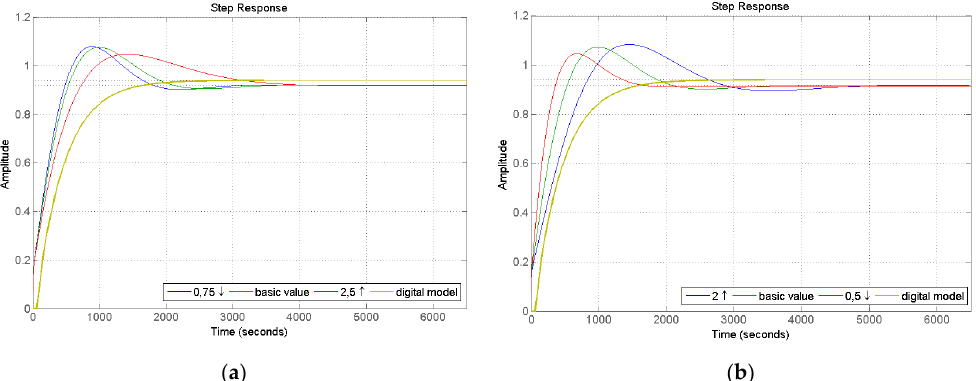
Figure 6. Segment G1 step ( a ) and frequency responses ( b ) for simulation of changes in ambient temperature.